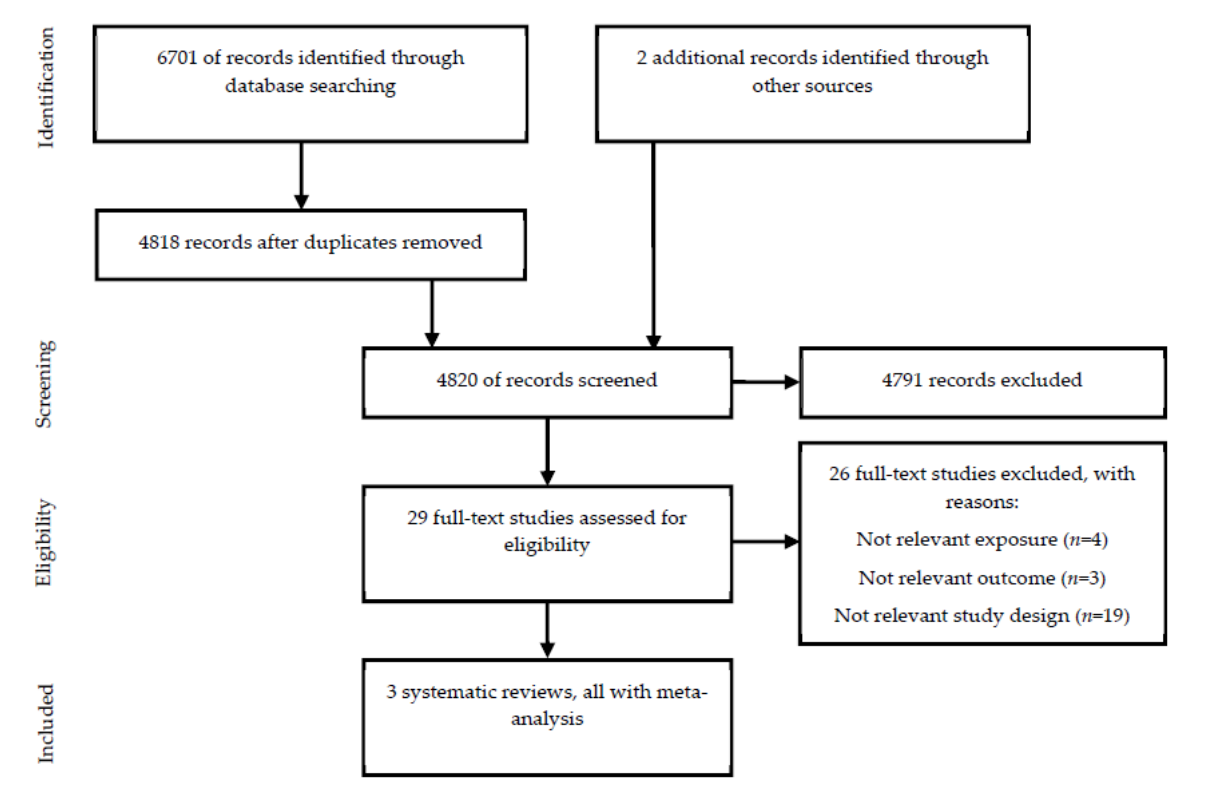
Figure 1. Flow diagram summarizing the study selection processes.